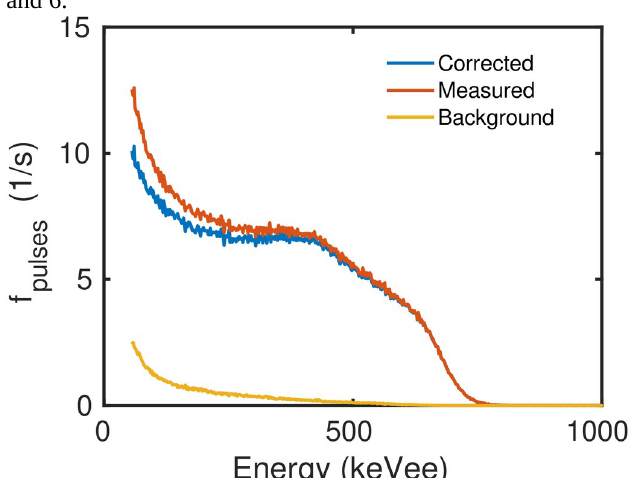
with PYR luminophore is